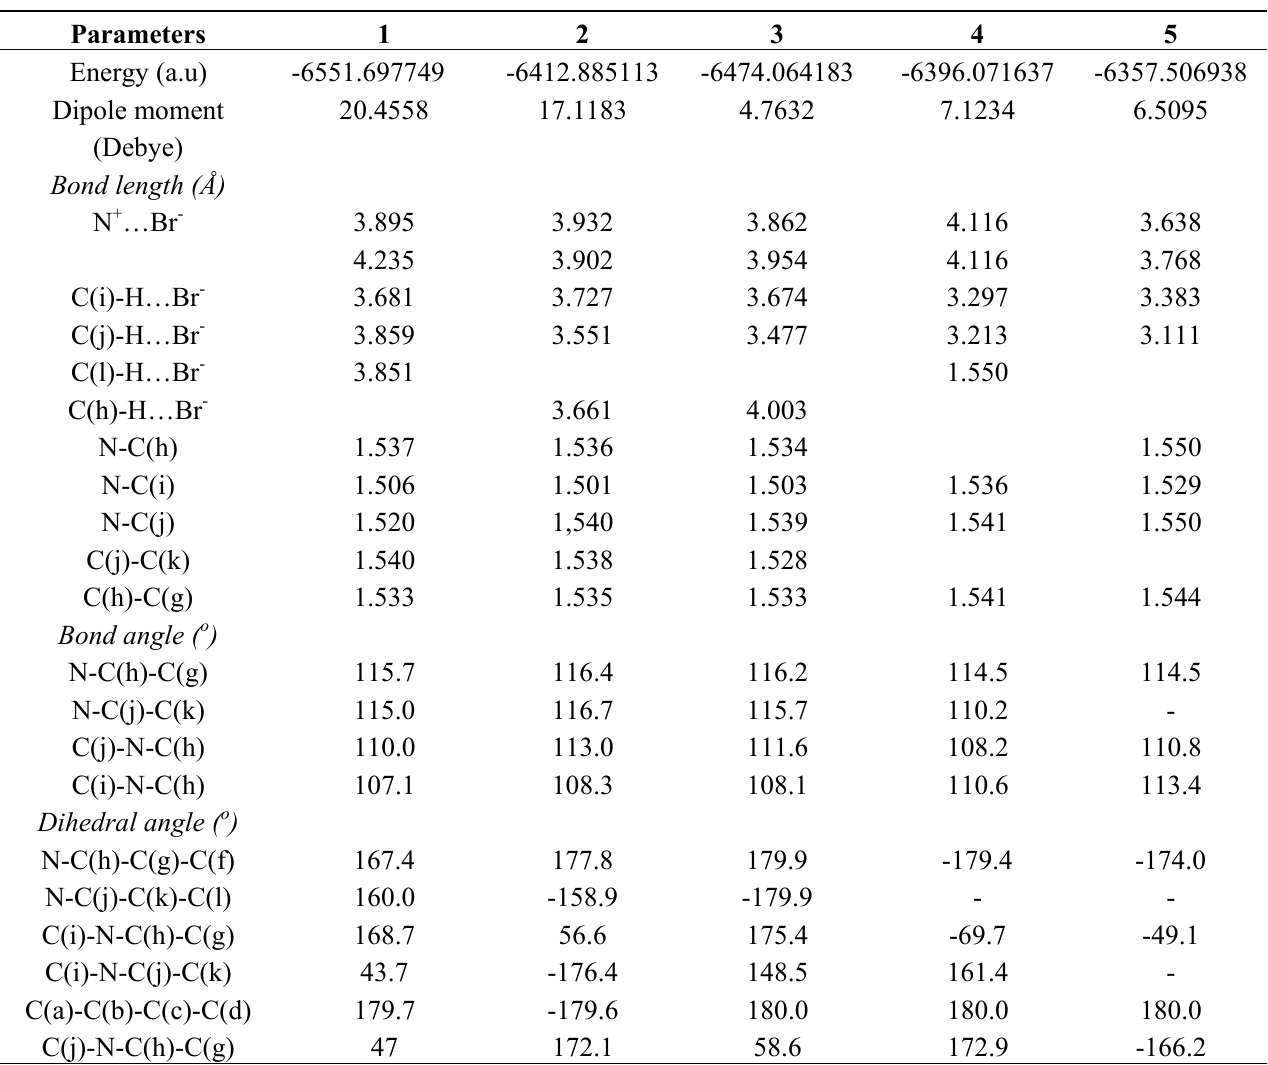
Table 1. Selected parameters of investigated compounds 1-5 calculated by the Hartree- Fock/3-21G(d,p)